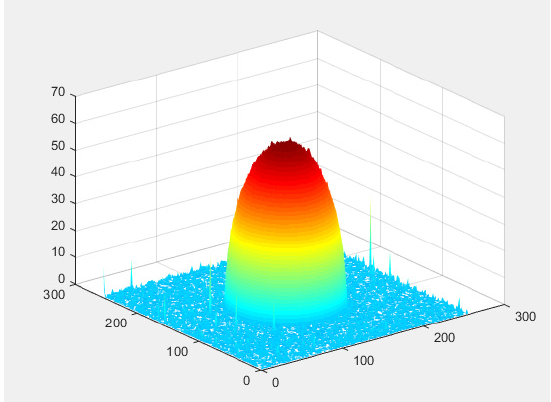
Figure 14. ( a – h ) The original eight fringe images; ( i – p ) the eight original images are restored again by filtering.